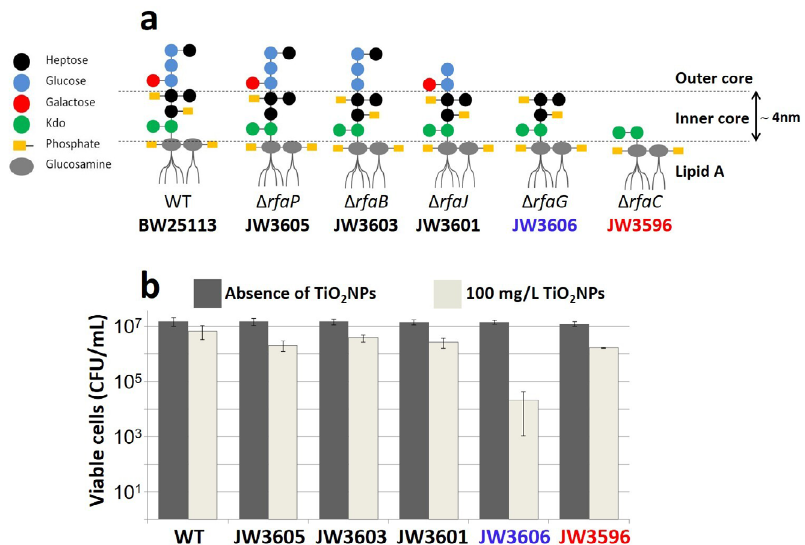
Fig. 1 Lipopolysaccharide phenotypes and preliminary assessment of TiO 2 NP toxicity towards E. coli K12 rfa- mutants at high TiO 2 NP concentration. a E. coli K12 rfa- mutants, associated LPS phenotypes, and corresponding mutations in the rfa operon 41 . b Number of viable cells in CFU/mL unexposed and exposed to 100 mg/L TiO 2 NPs for 20 h in the dark. n = 4 for each tested condition.